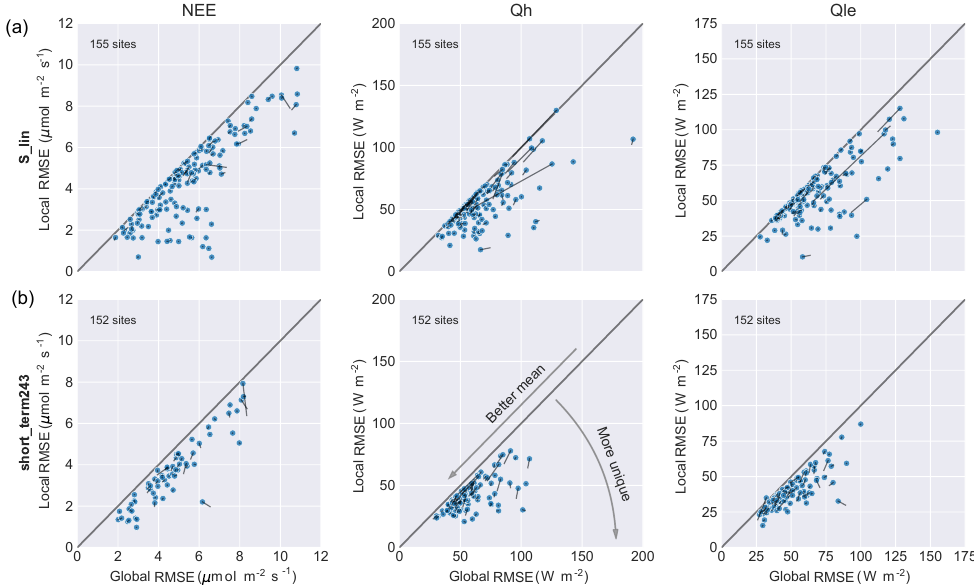
Figure 1. RMSE values for the global ( x axis) and local ( y axis) model simulations. Columns show the three fluxes, panel (a) shows data for S_lin, and panel (b) for short_term243. The tails of each point show where the local and global RMSE values would be if the same QC flags were used for training and evaluating (the intersection of meteorological and flux QC flags). Tails pointing toward the zero in each axis indicate the model would have performed better using these QC flags. In other words, a tail pointing towards the origin means that our evaluation method has a bias toward worse mean RMSE, and a tail pointing clockwise from the origin indicates that our method has a bias towards lower